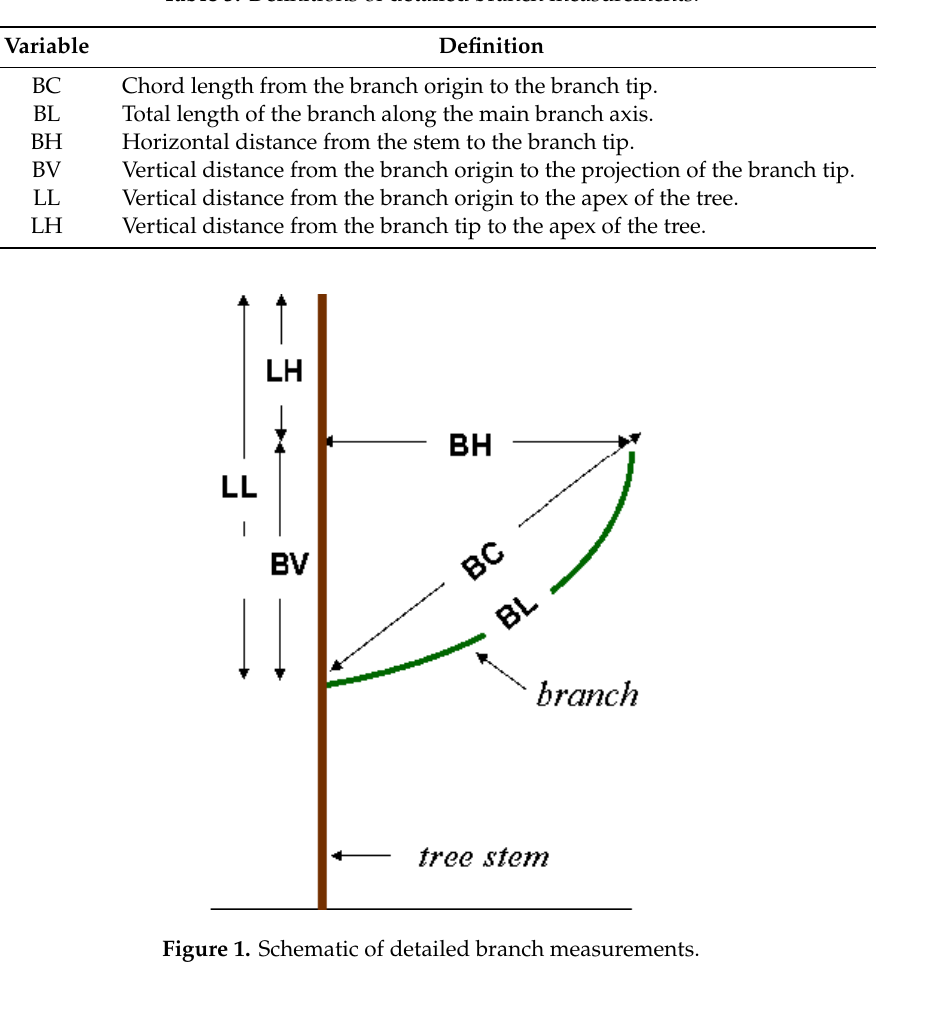
Table 3. Definitions of detailed branch measurements.